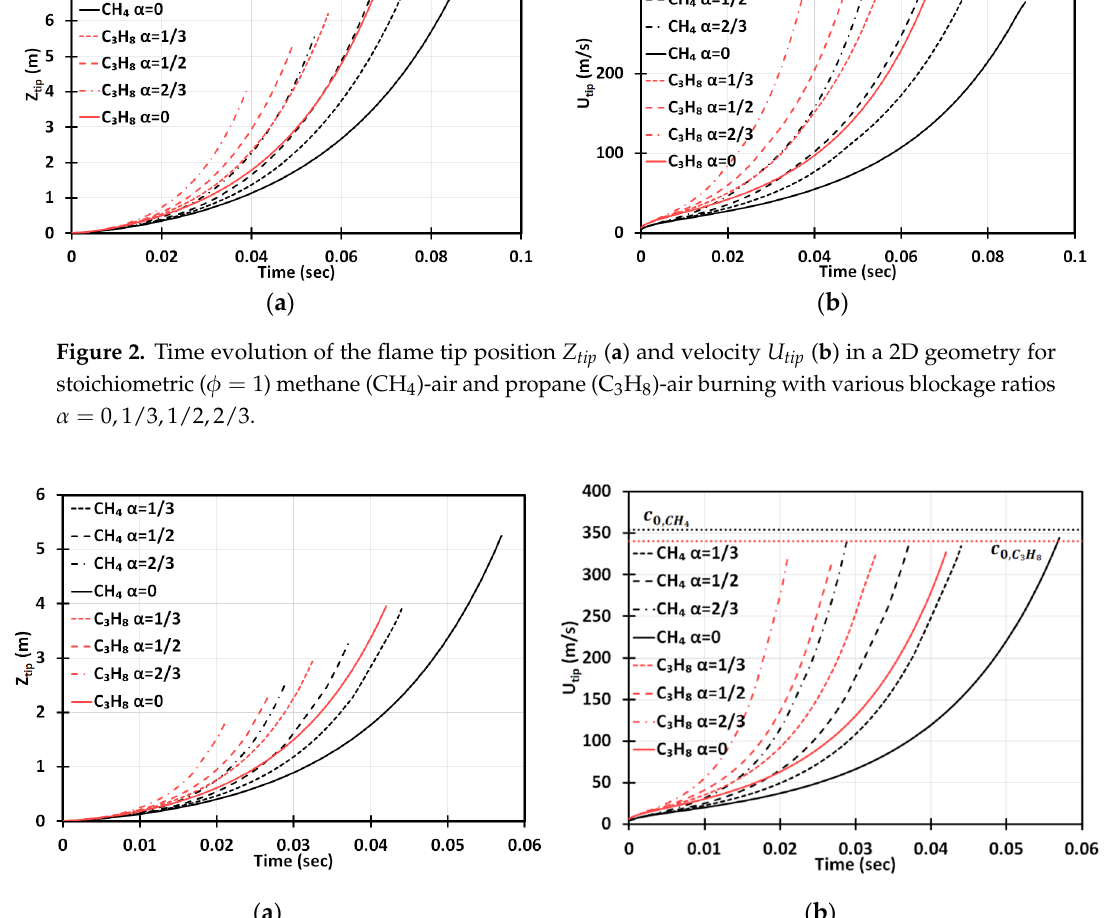
Figure 2. Time evolution of the flame tip position (cid:1852) (cid:3047)(cid:3036)(cid:3043) ( a ) and velocity (cid:1847) (cid:3047)(cid:3036)(cid:3043) ( b ) in a 2D geometry for stoichiometric ( (cid:2038) = 1 ) methane (CH 4 )-air and propane (C 3 H 8 )-air burning with various blockage ratios (cid:2009) = 0, 1 3,⁄ 1 2,⁄ 2 3⁄ .